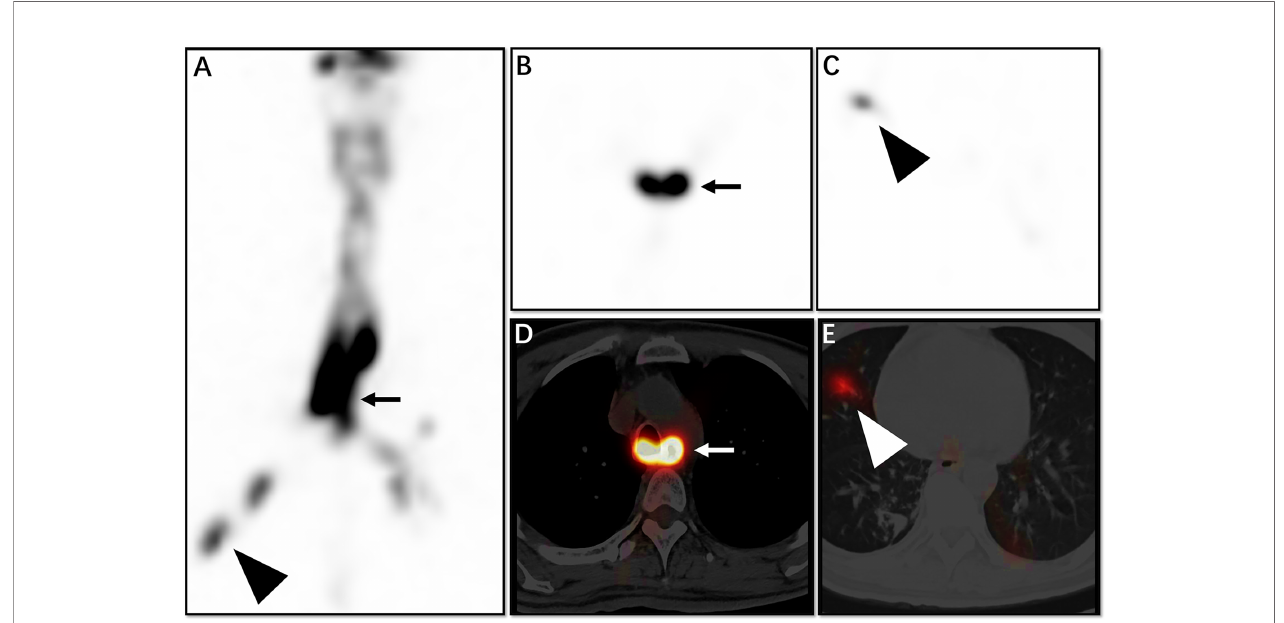
FIGURE 3 | This 43-year-old man had inability to swallow and recurrent coughing. Whole SPECT imaging (A) , tomography SPECT imaging (B, C) , and fl ued SPECT/CT imaging (D, E) are demonstrated. We see from the image that the opening of the oesophageal fi stula is located at the plane of the main bronchial bifurcation ( A, B, D , straight arrow), and imaging agent is also seen at the distal bronchus ( A, C, E , triangular